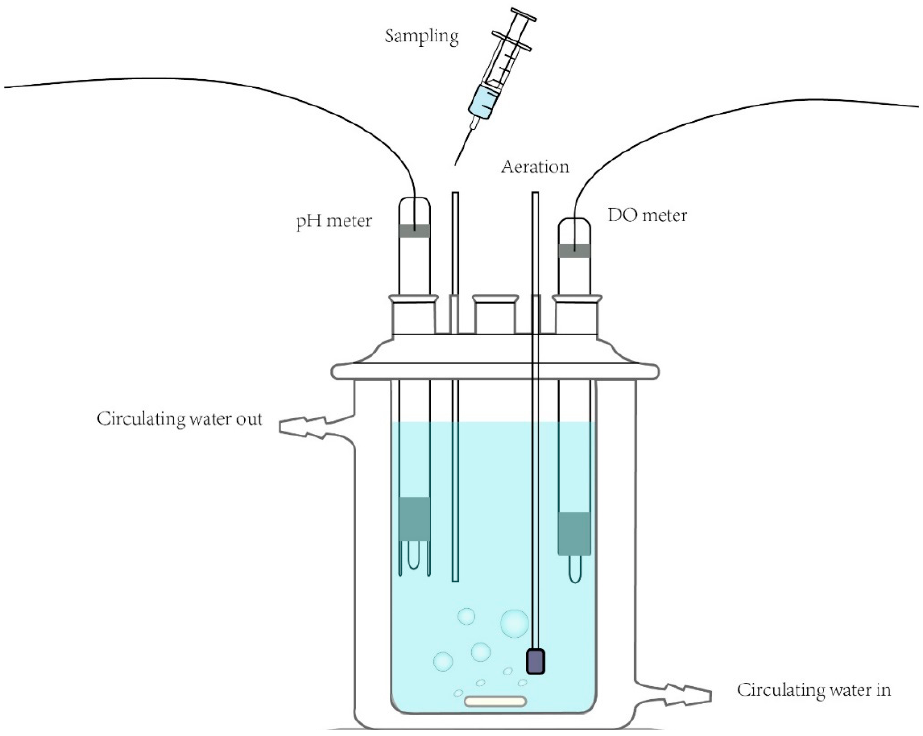
Figure 6. Schematic of experimental setup.